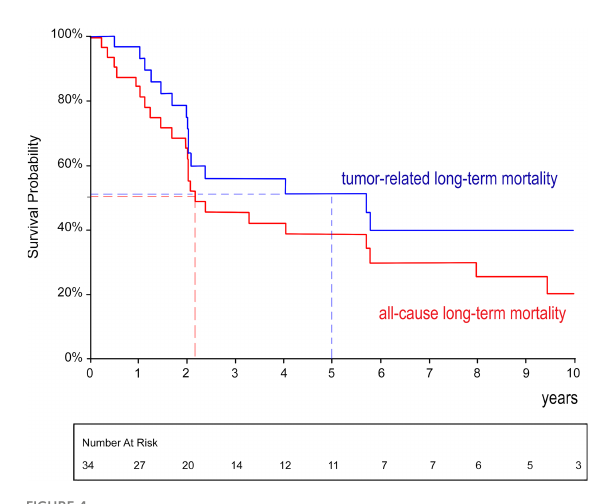
FIGURE 4 Kaplan – Meier analysis of overall and cancer-related survival after radical surgery for renal cell carcinoma with level IV tumor